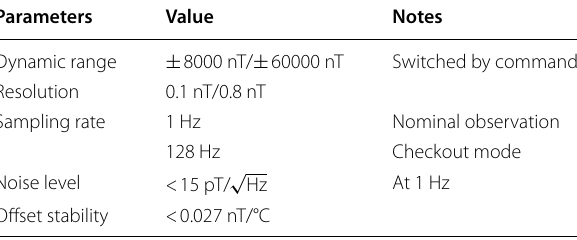
Table 3 Specifications of the MSA